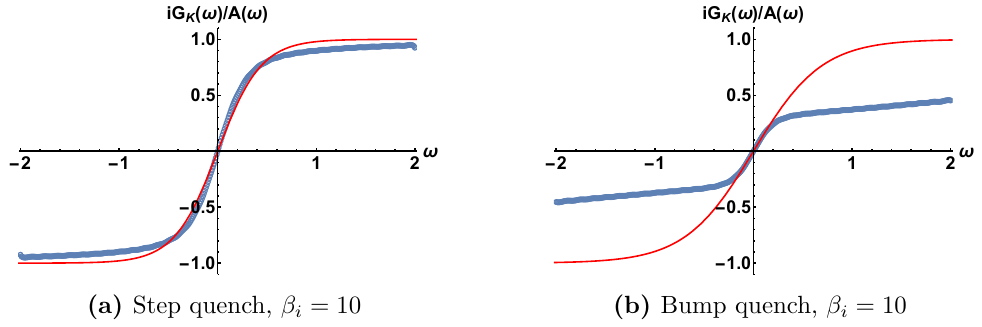
Figure 5. Plots of iG K ( ! ) =A ( ! ) for the equilibrated limits of (a) step quench and (b) bump quench. For both the quenches, we start from a thermal state of inverse temperature (cid:12) i = 10. The red lines are plots for the function tanh( (cid:12)!= 2) with the respective (cid:12) f ’s.